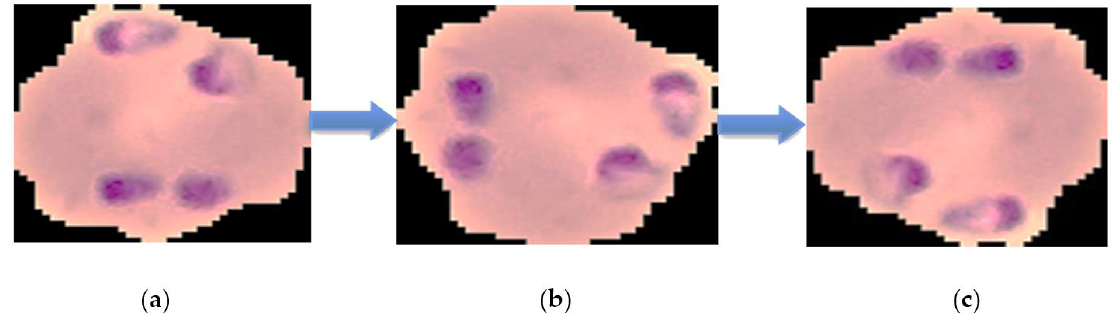
Figure 6. The results of malaria images in the dataset using a region of interest (ROI) boundary and the rotation technique: ( a ) the malaria-infected red blood cells were tilted 90 degrees by rotation; ( b ) the malaria-infected red blood cells were tilted 180 degrees by rotation; and ( c ) the malaria-infected red blood cells were tilted 270 degrees by rotation.